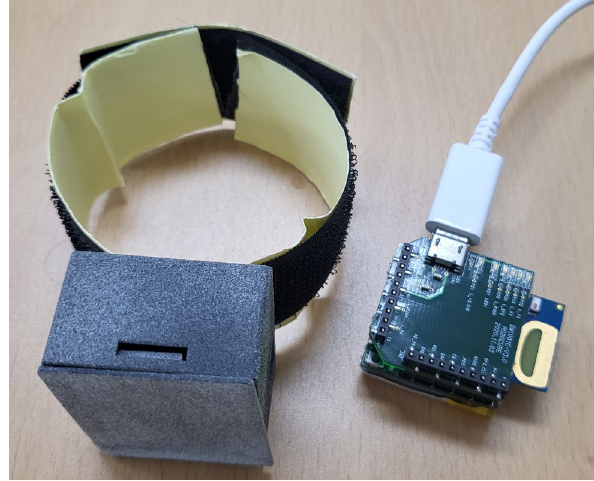
Figure 4. IMU sensor. Table 2. Status of constructed dataset.